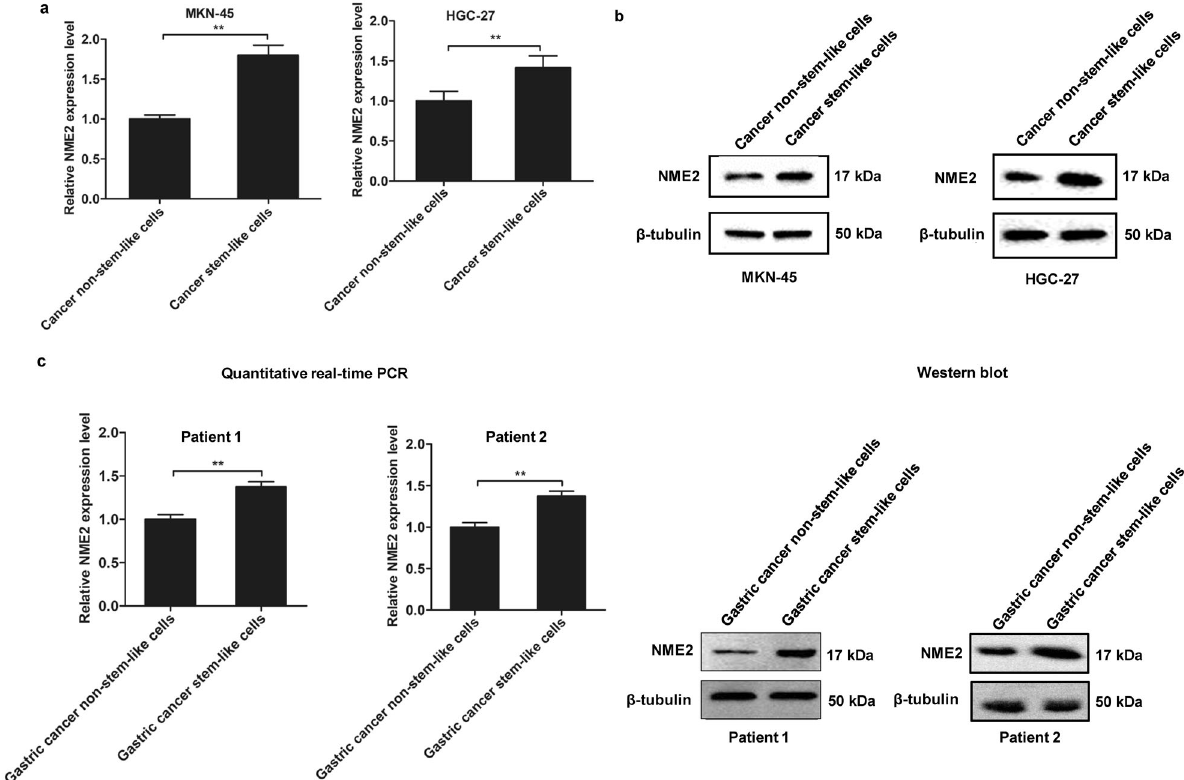
Fig. 2 Upregulation of NME2 in gastric cancer stem-like cells. a Differential expression of NME2 in gastric cancer stem-like cells and cancer non-stem-like cells. Quantitative real-time PCR was conducted to detect the NME2 mRNA level. b Western blot analysis of NME2 protein in gastric cancer stem-like cells and cancer non-stem-like cells. β -Tubulin was used as a control. c The expression of NME2 in gastric cancer stem- like cells or cancer non-stem-like cells sorted from the solid tumor of two gastric cancer patients. The mRNA level and the protein level of NME2 were examined with quantitative real-time PCR (left) and western blot (right),